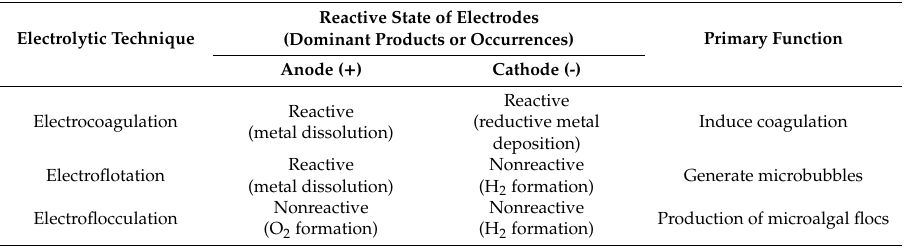
Table 5. Simplified description of the main electrolytic dewatering techniques in microalgal biomass